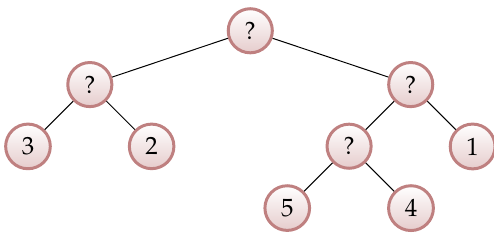
Figure 2. A balanced tournament of five